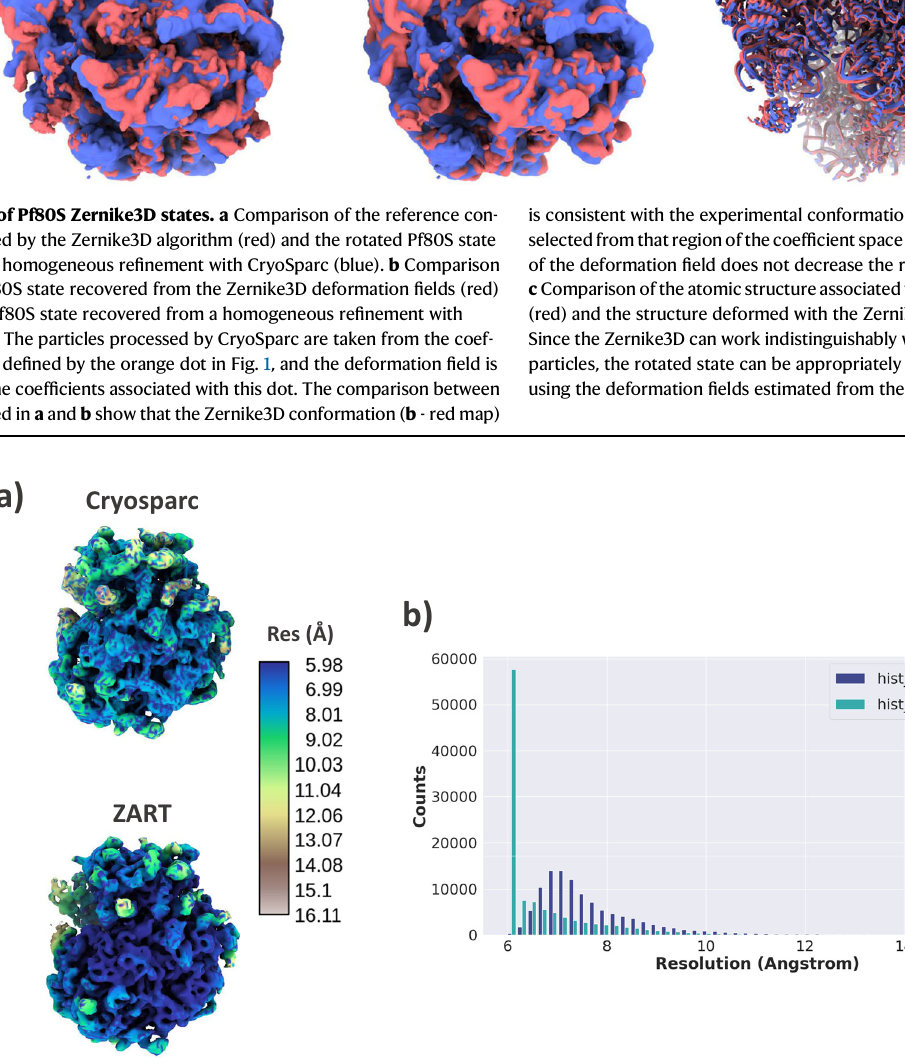
Fig. 3 | Analysis of EMPIAR-10028 ZART reconstruction. a Comparison of P. falciparum 80S ribosome map re fi ned with CryoSparc (blue) and the motion- correctedmaprecoverwithourZARTalgorithm.Thecolormaprepresentsthelocal resolution estimation for each voxel computed with BlocRes 23 . The ZART